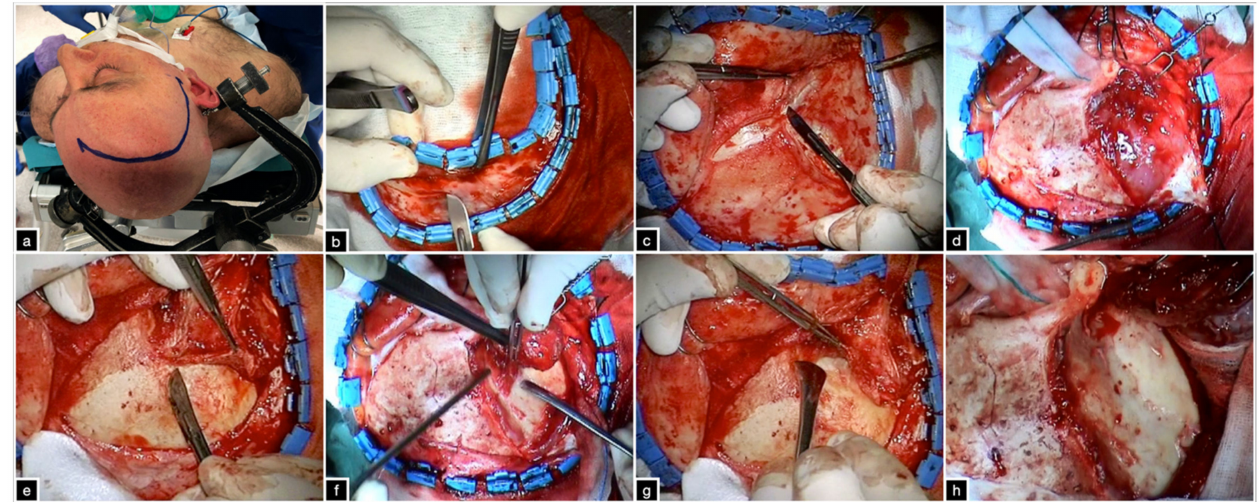
Figure 2. ( a ) Position and skin incision. ( b – d ) Galea-pericranium vascularized flap and subfascial dis- section of the superficial temporal fascia. ( e – h ) Retrograde subperiosteal dissection of the temporalis muscle according to the Oikawa technique and skeletonization of the orbitopterional